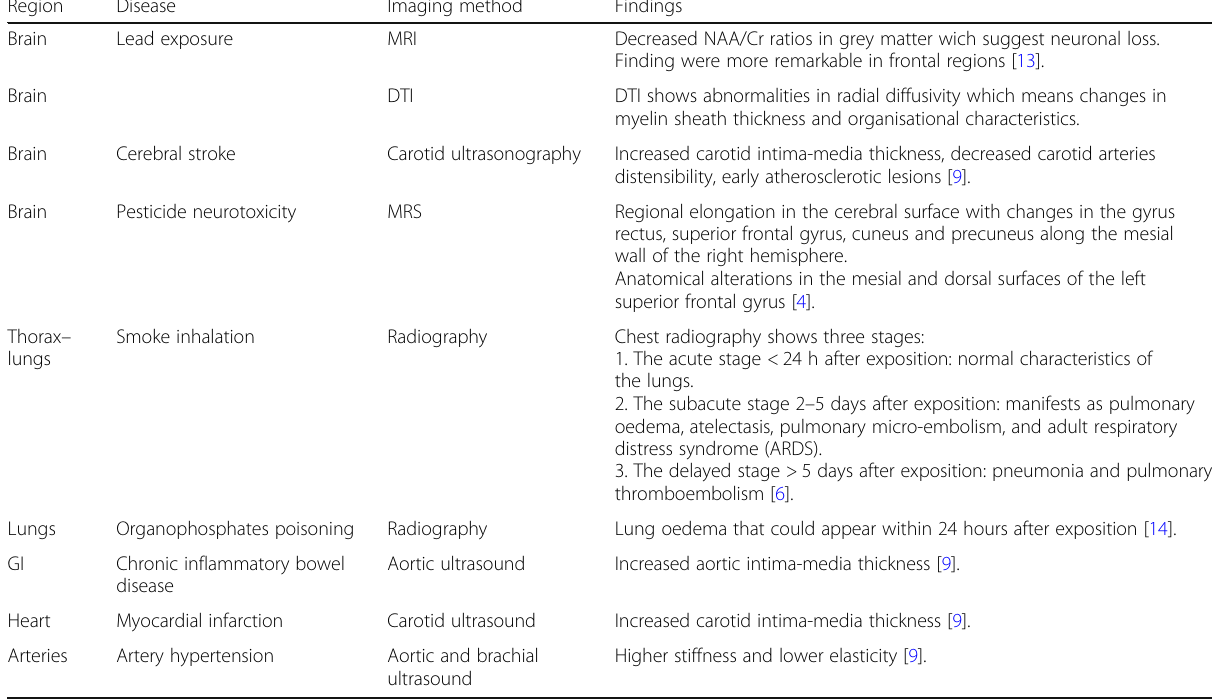
Table 1 Anatomic regions affected by environmental diseases that have been assessed with imaging methods